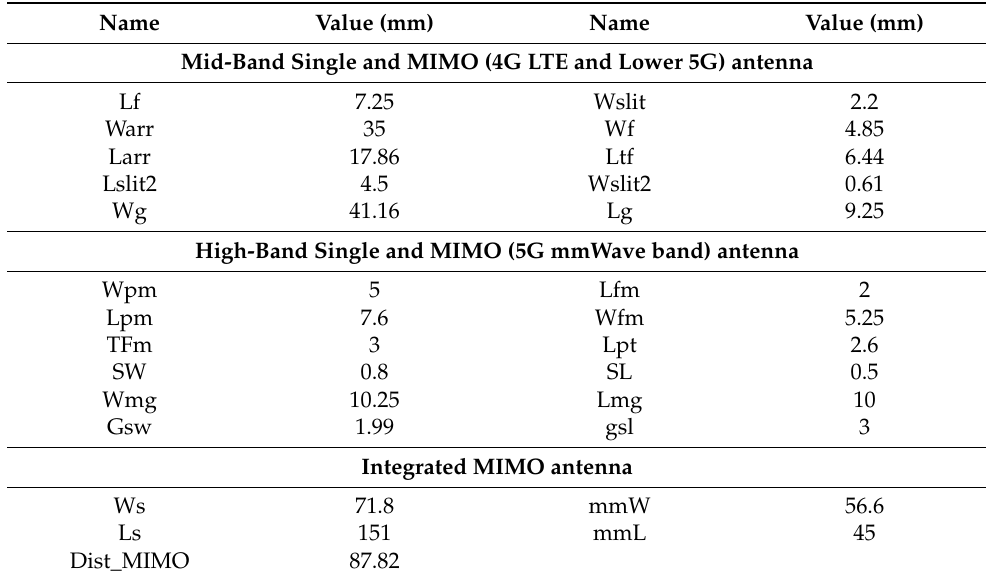
Table 1. Dimensions of the proposed